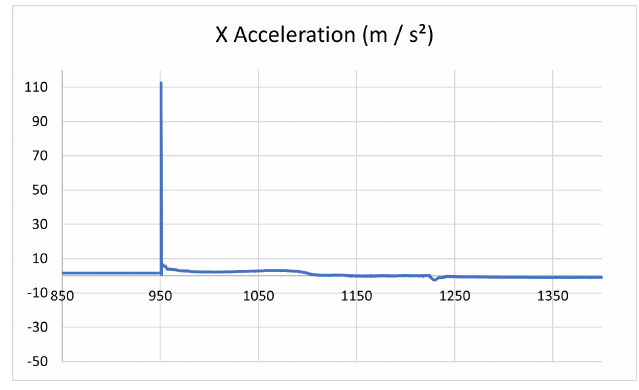
Figure 4. X-acceleration Validation.